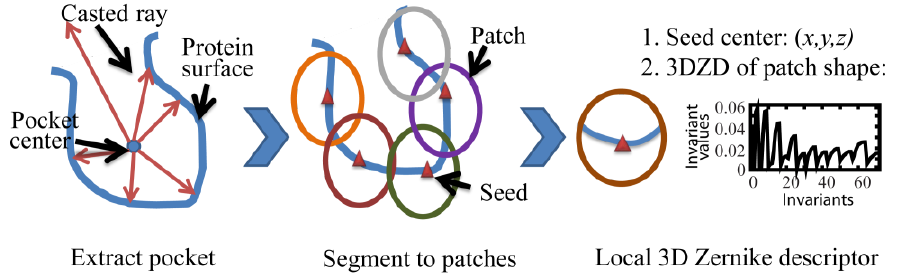
Figure 2. Flow chart of pocket extraction and patch descriptor